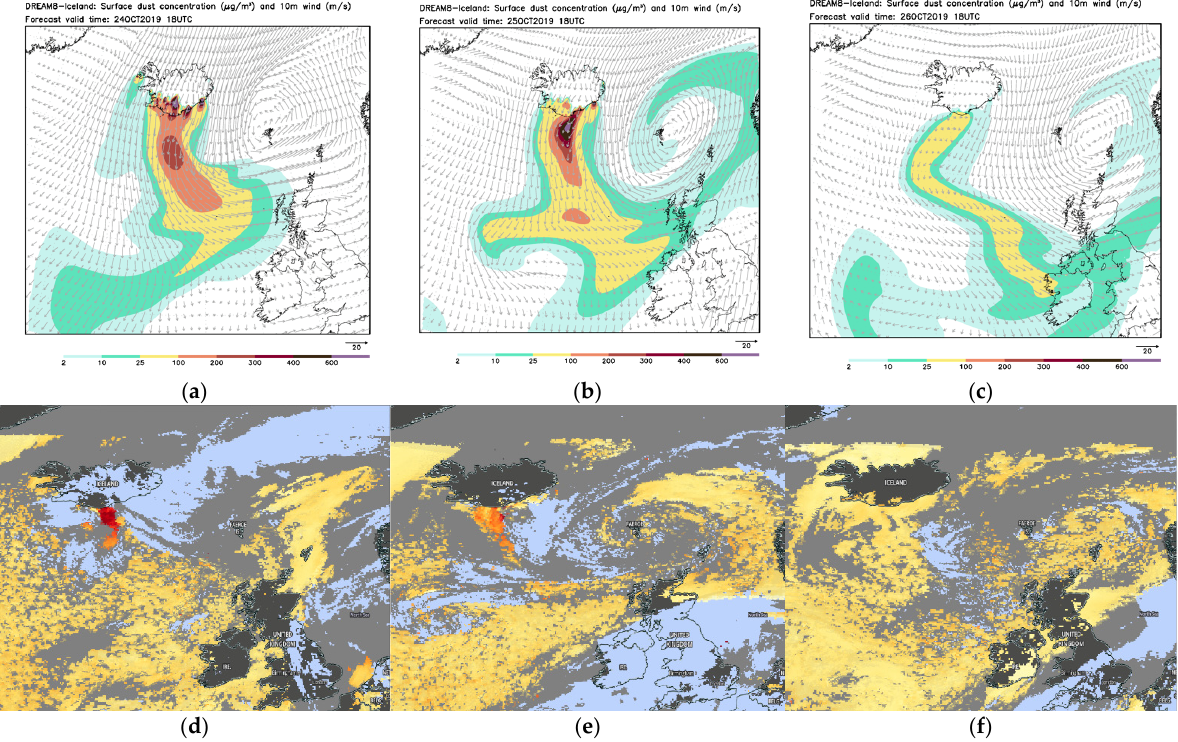
Figure 20. Dust storm 24–26 October 2019. ( a – c ) Model surface dust concentration (µgm − 3 ); and ( d – f ) MODIS AOD. According to the HYSPLIT trajectories (Figure 21a,b), which are in compliance with the predicted surface dust concentration and the observed PM10 at Mace Head station (Figure 21c), the Icelandic dust approached Ireland in the evening hours of 25 October 2019 and it persisted all the next day. The predicted dust concentration shows maximum values for 26 October, as confirmed by the observed PM10, although the first peak in the model profile (early morning hours on 26 October) is overestimating the observed PM values. The model also produced an increased concentration before the observed increase, most probably because of the same reasons, as in previous case studies (wind-filled fore- cast, sources specification and point-on-point verification approach).